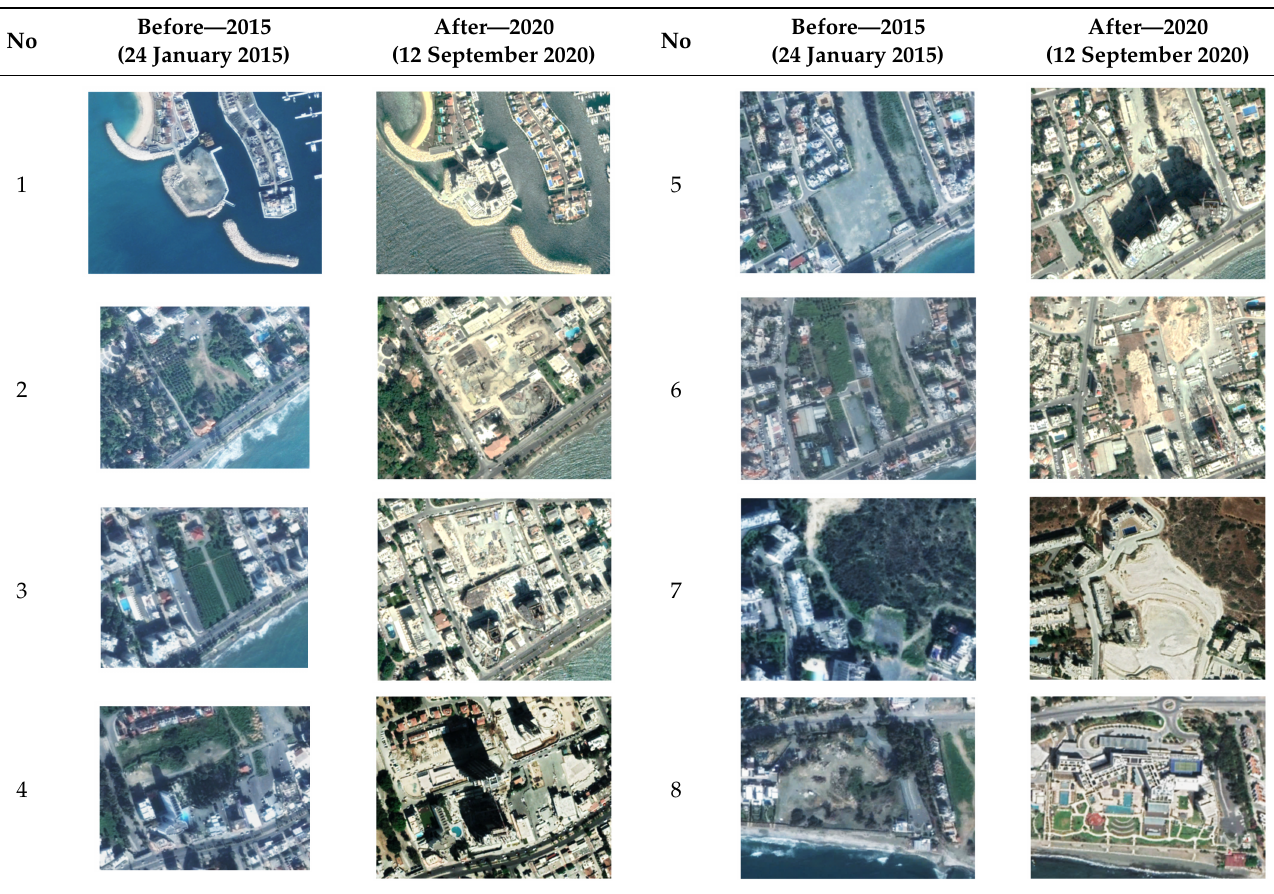
Table 1. Examples of land-use changes (construction areas) thought the Google Earth satellite images, during the period 2015–2020 for the selected areas, as shown in Figure